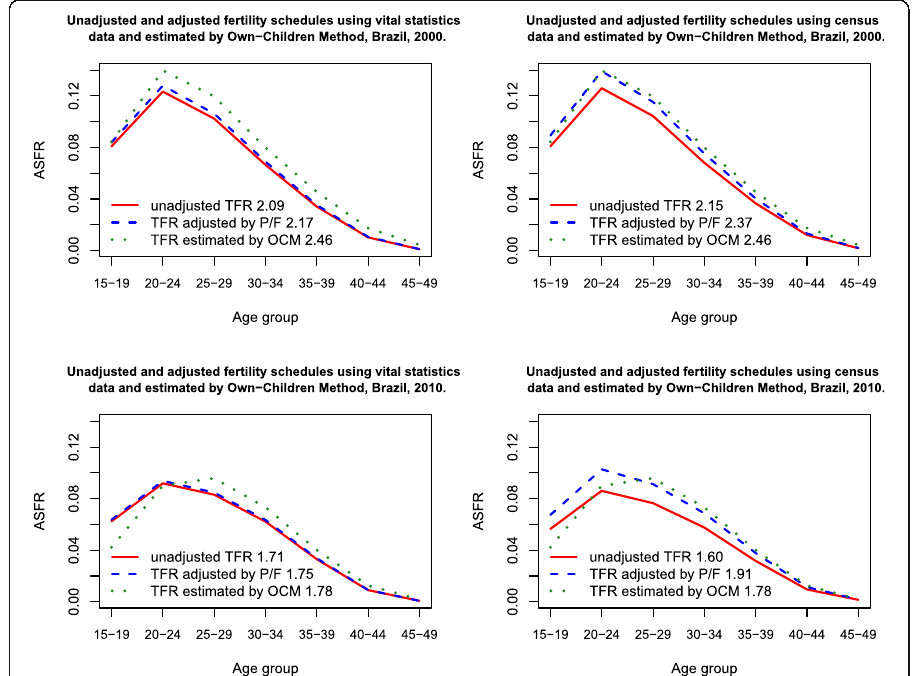
Fig. 2 Fertility schedules estimated by different methods and different data sources, Brazil, 2000 to